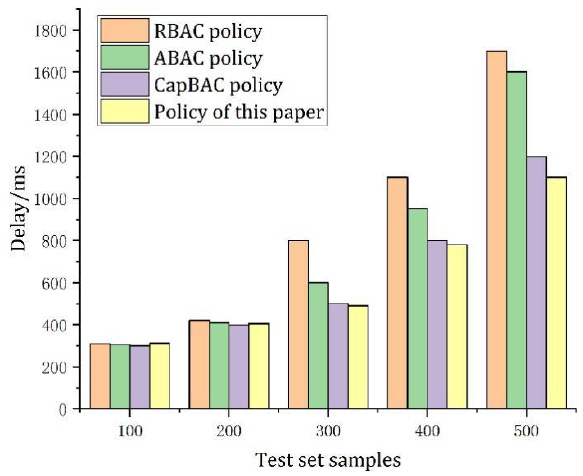
Figure 10. Delay comparison of four policies.